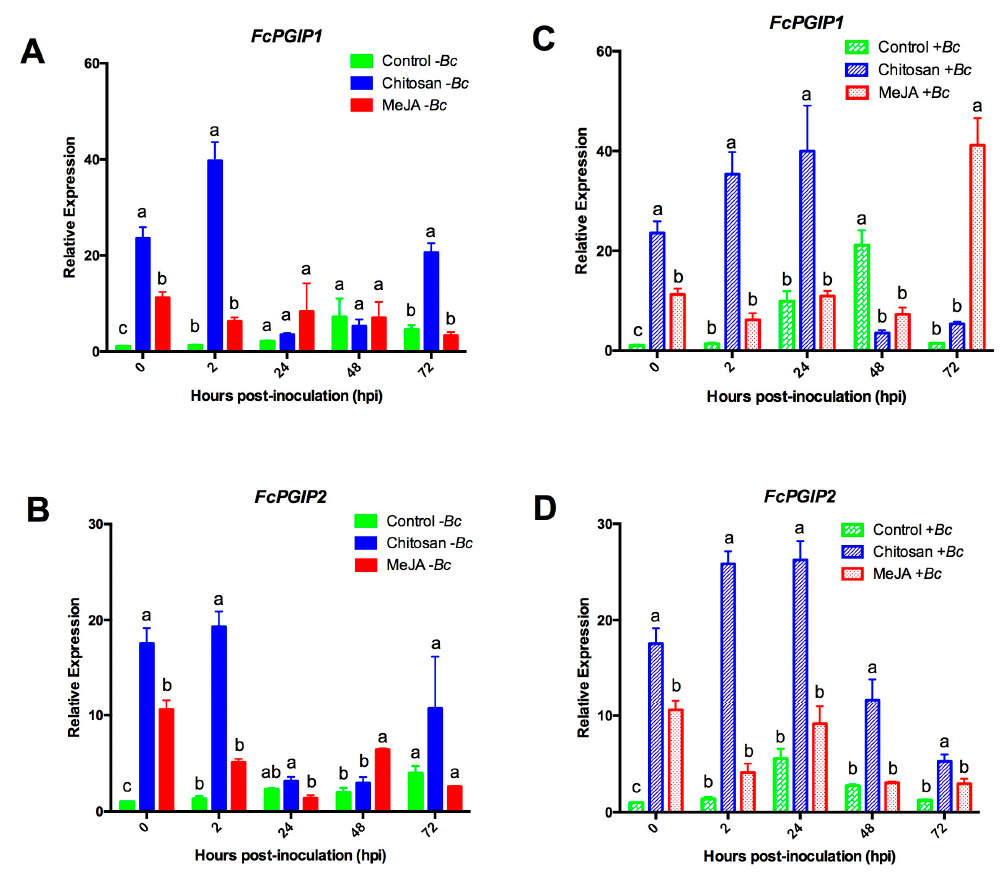
Figure 3. Expression profiles for polygalacturonase inhibiting protein-encoding genes ( PGIP s) in Fragaria chiloensis fruit treated with methyl jasmonate (MeJA) or chitosan from 0 to 72 h post inoculation (hpi) with or without Botrytis cinerea spores . Changes in relative expression of FcPGIP1 and FcPGIP2 in fruit inoculated without (– Bc ) ( A , B ) and with (+ Bc ) B. cinerea spores ( C , D ), respectively, at 0, 2, 24, 48, and 72 hpi. Data were analyzed by ANOVA test and differences between means ± SE ( n = 3) were determined using the Tukey test. Different letters indicate significant differences between treatments ( p < 0.05) for each hpi. For experimental details see the Materials and Methods Section.